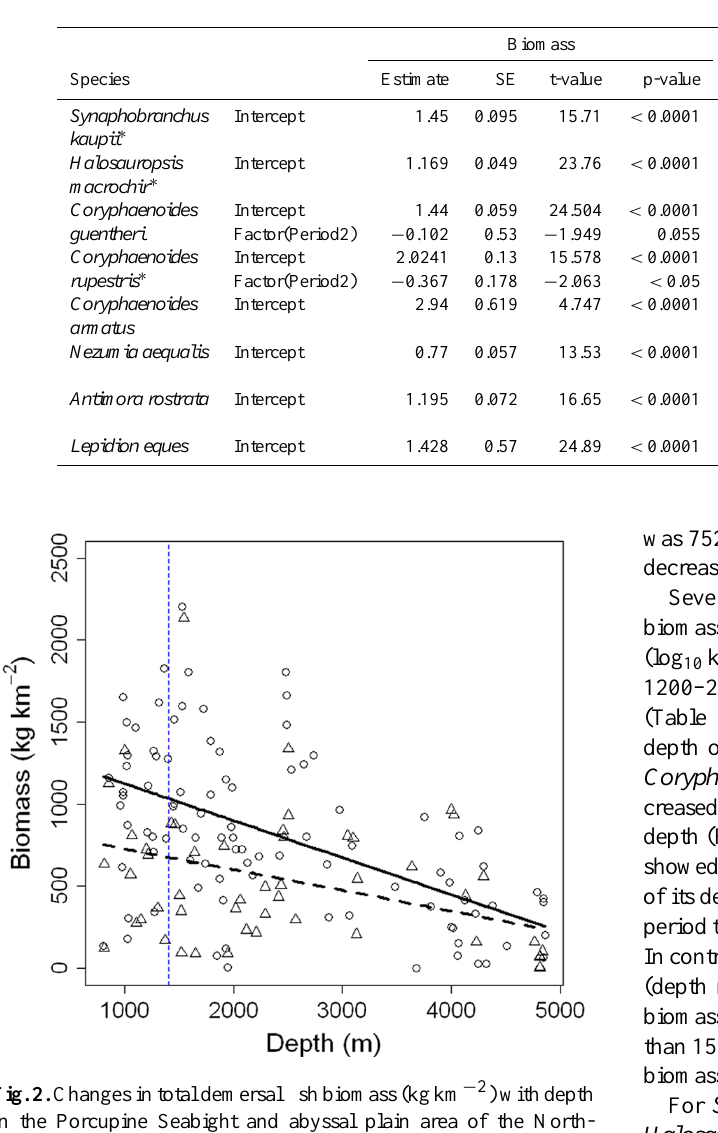
Table 1. Summary results for the 8 most dominant species in terms of total biomass (kgkm − 2 ) at the Porcupine Seabight and abyssal plain. ∗ Species biomass distributions were analysed using generalised additive mixed modelling (GAMM). Here the terms “Period1” refer the early period and “Period2” the late period of trawling. SE represents the Standard error and Edf is the estimated degrees of freedom for the smoothers obtained by cross-validation. s(Depth) refers to a smoother for depth irrespective of trawling period and s(Depth):Factor(Period2) denotes that there is a separate smoother for changes in biomass with depth in Period2.